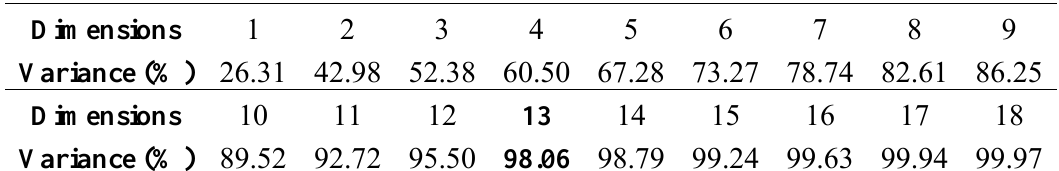
Table 6. Detailed data of PCA on 19 features.